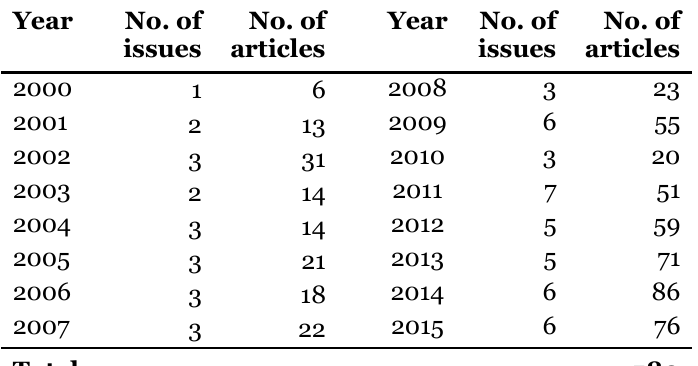
Number of Articles per Year Published in IRRODL (Volumes 1–16)